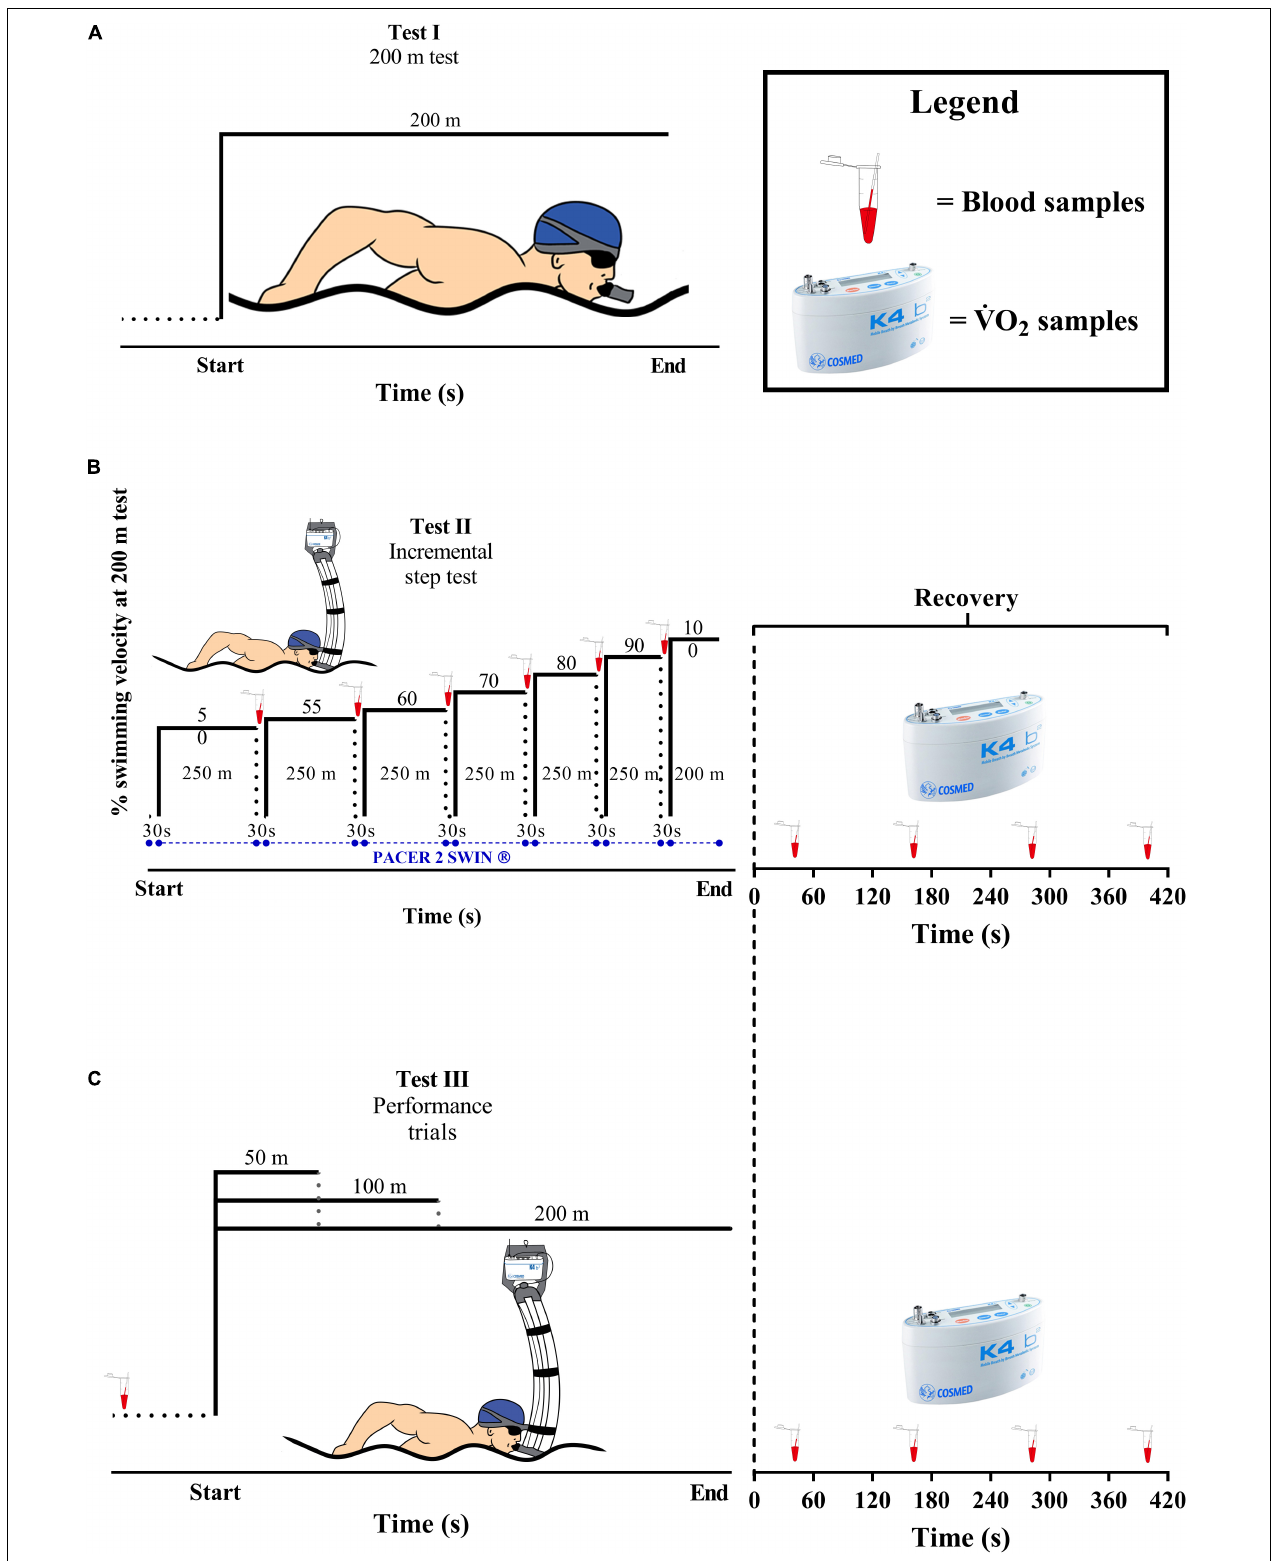
FIGURE 1 | An overview of the experimental protocol. (A) The 200 m maximal test. (B) The incremental step test. (C) 50, 100, and 200 m maximal trials.